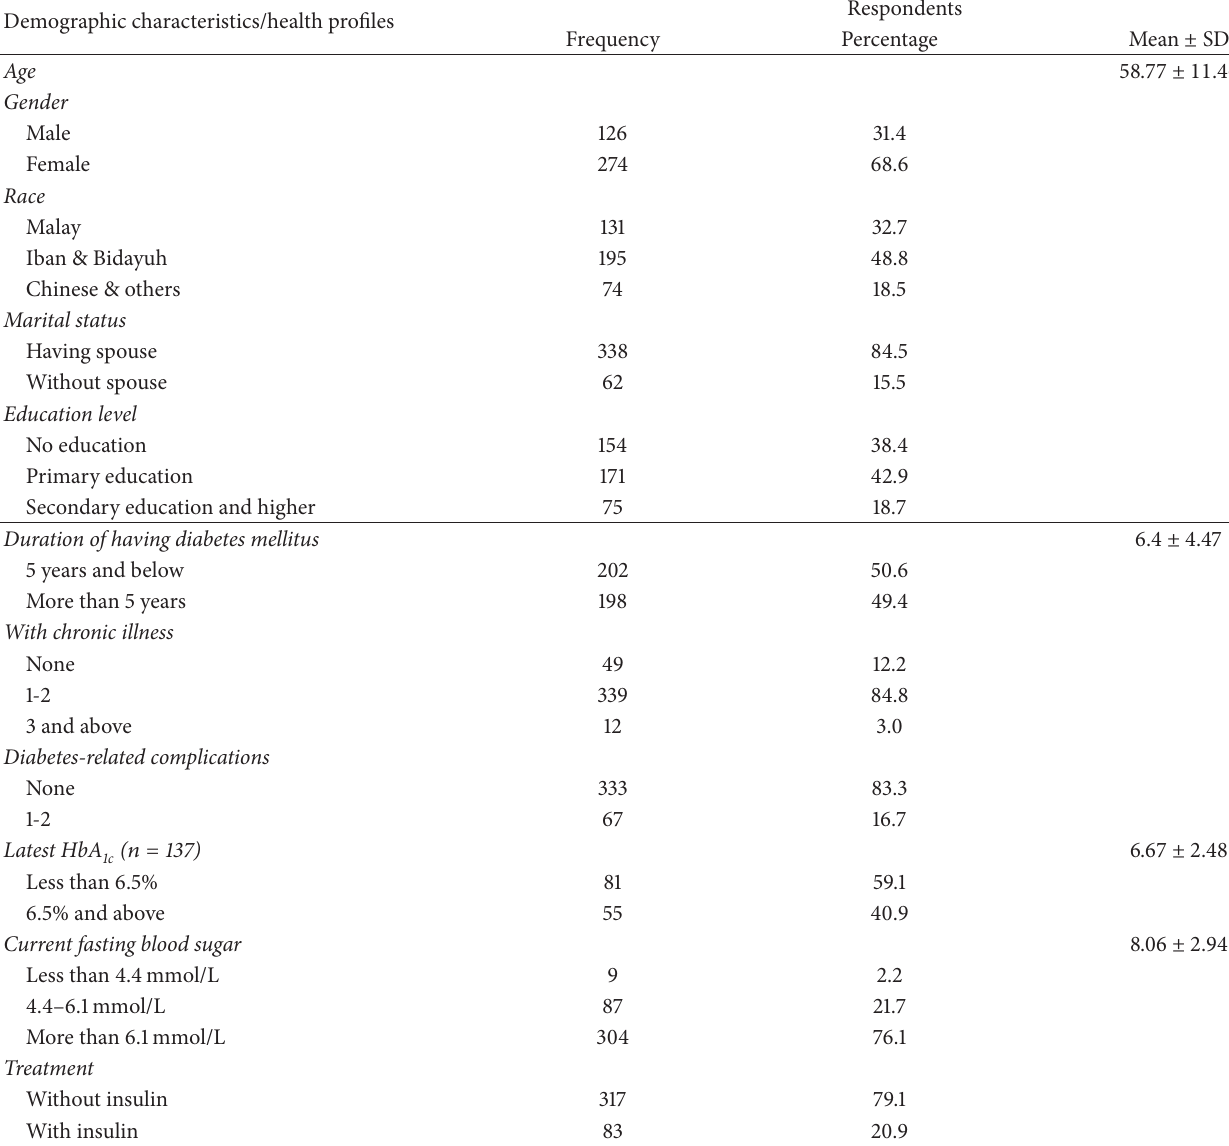
Table 1: Sociodemographic characteristics and health profile of the respondents ( 𝑛 = 400